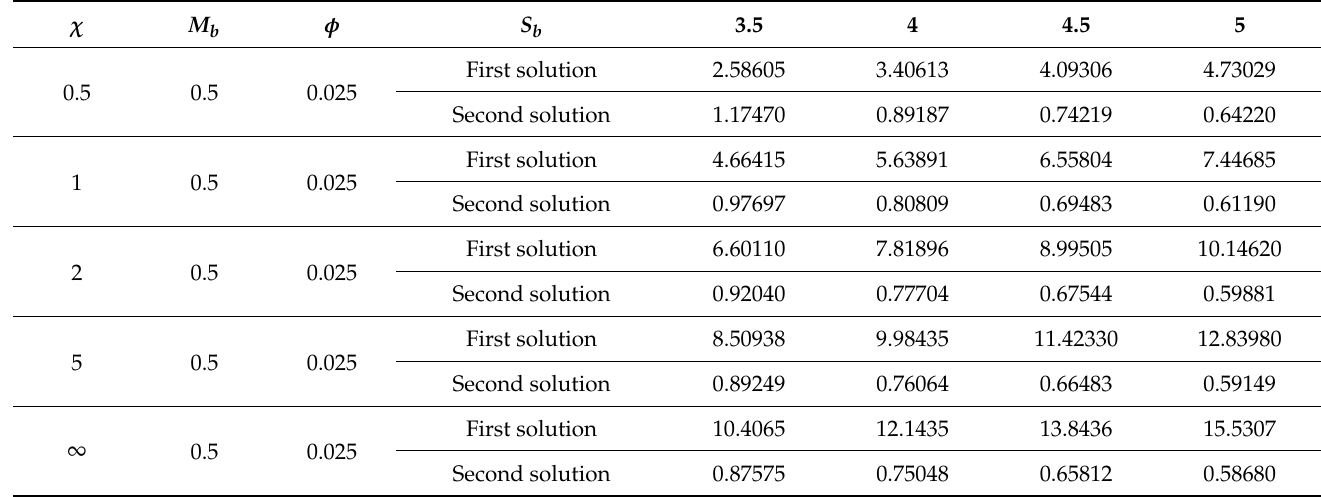
(cid:16) (cid:17) G (cid:48)(cid:48) ( 0 ) for distinct values of S b , χ , φ , and M b . µ nf / µ f